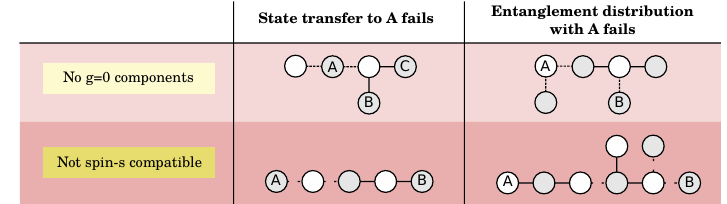
Figure 4: Example issues that occur when graph requirements are not fulfilled. In the top row, party A cannot be disconnected in such a way that all other components have g = 0, eventually breaking spin- s compatibility when the dotted couplings are set to 0. In the bottom row, the networks are such that A and B could in principle complete both protocols successfully, but during each protocol, disconnections are made such that spin- s compatibility is broken. In each of these cases, the ground state of the relevant V could become s , m